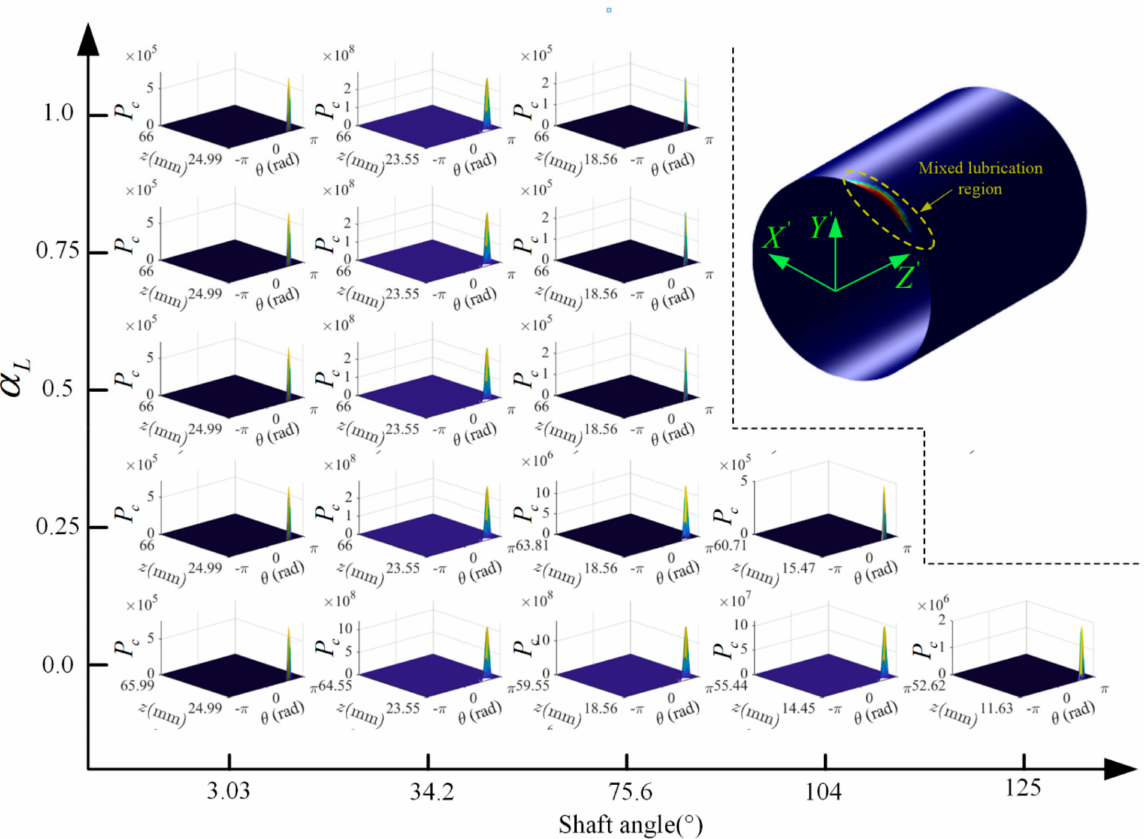
Figure 15. Variation of the mixed lubrication region with the shaft angle in cases with different cylinder lengths.